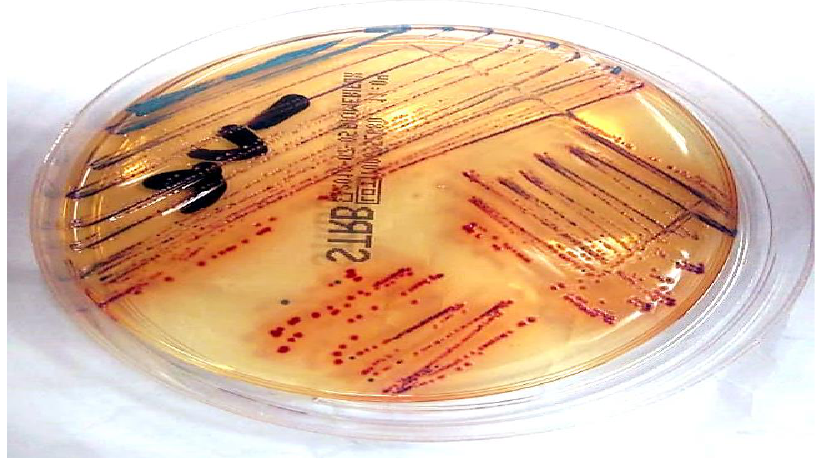
Figure 1. Chrom ID StreptoB agar showing the red colonies characteristic of Streptococcus